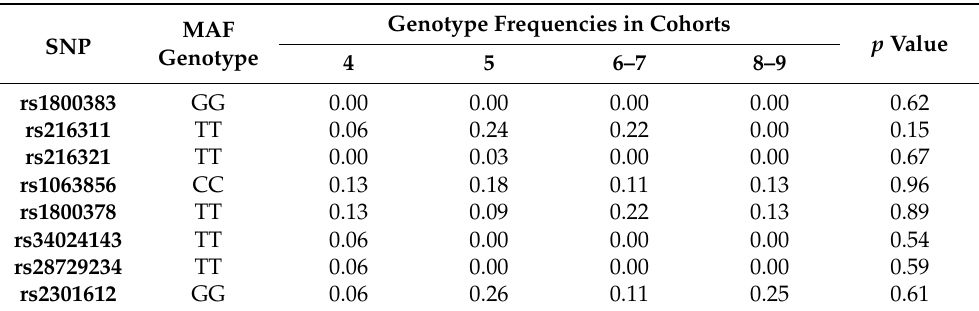
Table 5. Genotype frequencies of minor allele homozygotes in disease severity cohorts. Statistical analysis was performed with SPSS v17.0 software.